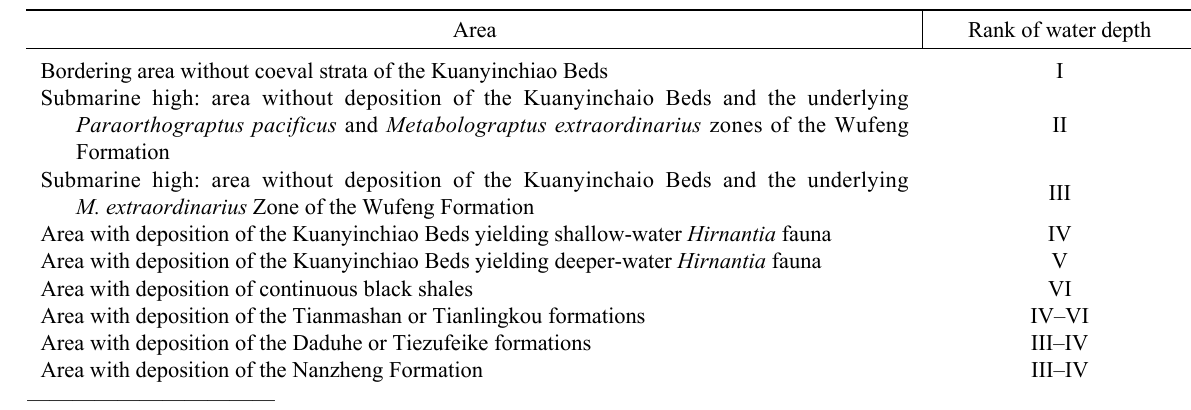
Table 1. Ranks of water depths of different facies Area Rank of water depth